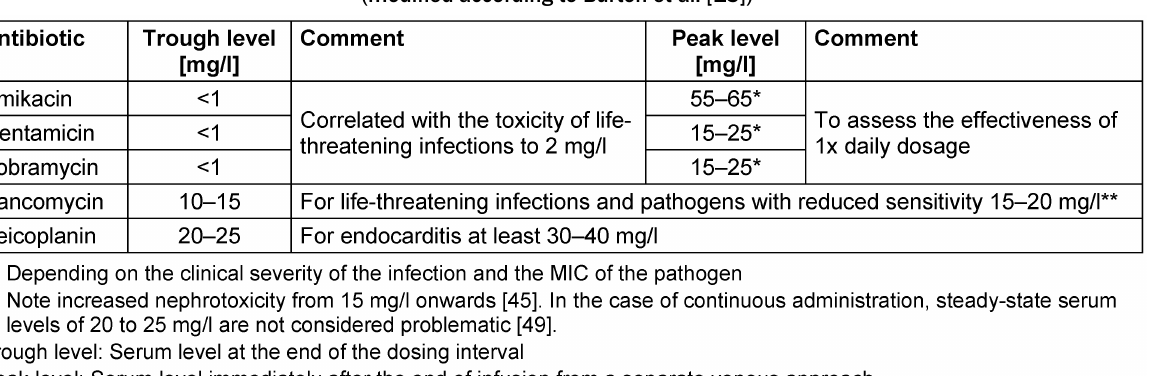
Table 4: Recommended target ranges for peak and trough levels in the TDM of aminoglycoside and glycopeptide antibiotics (modified according to Burton et al.